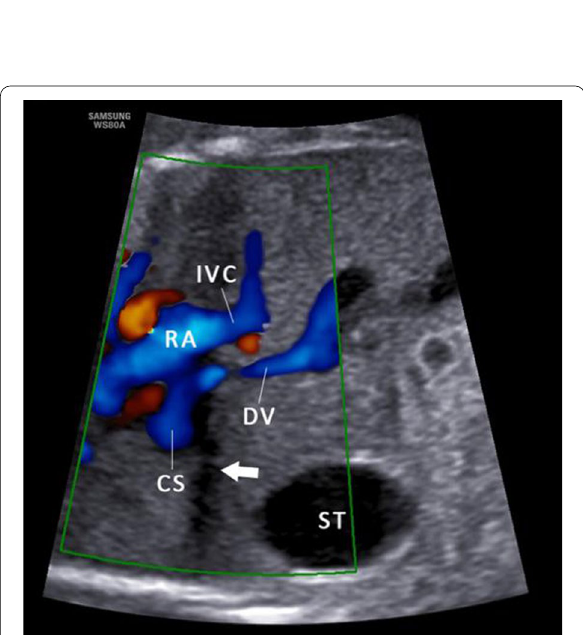
Fig. 17 Color Doppler flow imaging of DVSS. The DV connected with the CS rather than the